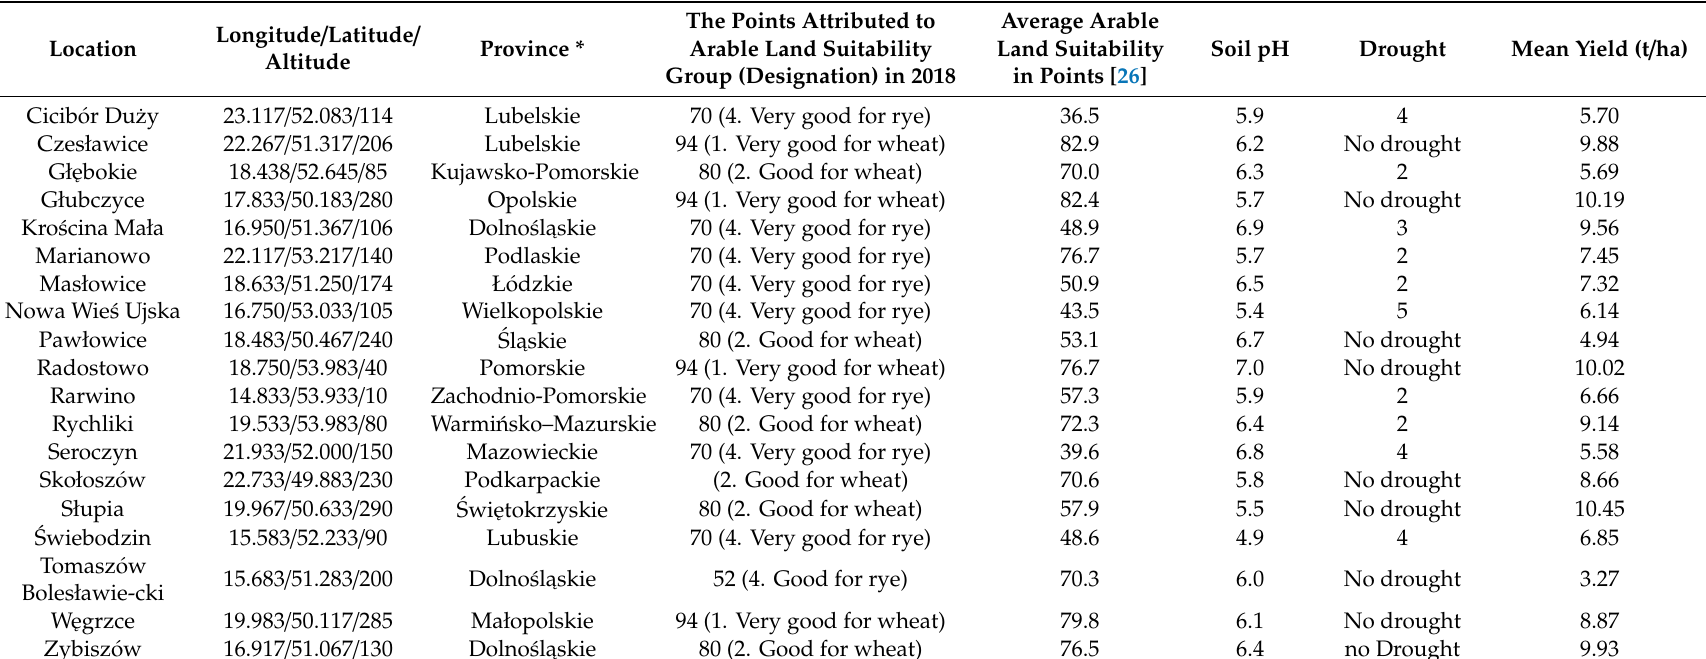
Table 1. Selected information on locations of post-registration multi-environment trials